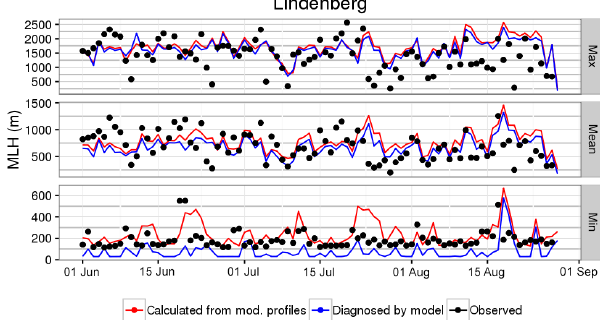
Figure 6. Daily minimum, mean and maximum mixing layer height as observed in Lindenberg, diagnosed by WRF-Chem and calcu- lated from modelled profiles of temperature, wind speed and hu- midity (base run, 1km × 1km horizontal